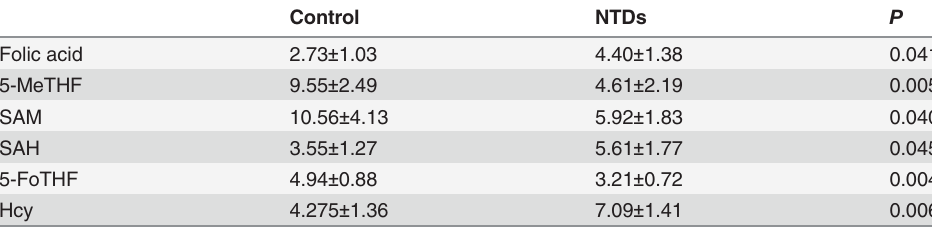
Table 1. Folate contents concentrations in control and NTDs from neural tube tissues( μ g g -1 protein).